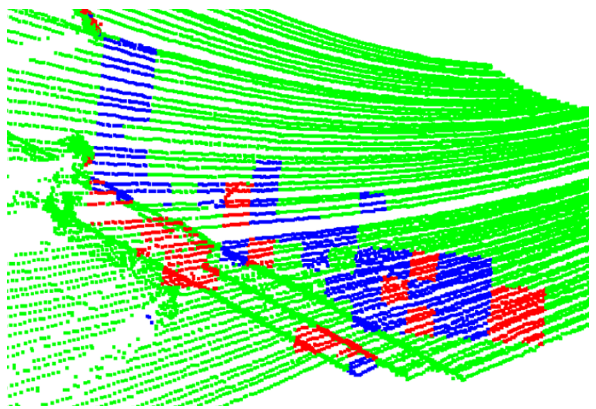
Figure 8. Solid ground (green) labeled as undetermined (blue) or moving (red), possibly due to measurements under unfavorable incidence angle.